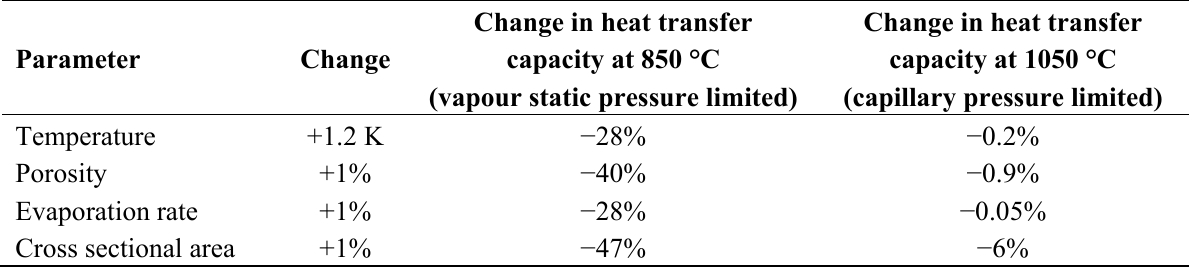
Table 1. The heat transfer capacity sensitivity due to parameter changes above and below P cap /P sat =